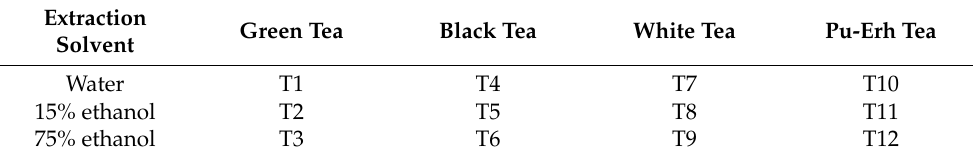
Table 1. Different tea extracts and their corresponding experimental numbers. Extraction Green Solvent